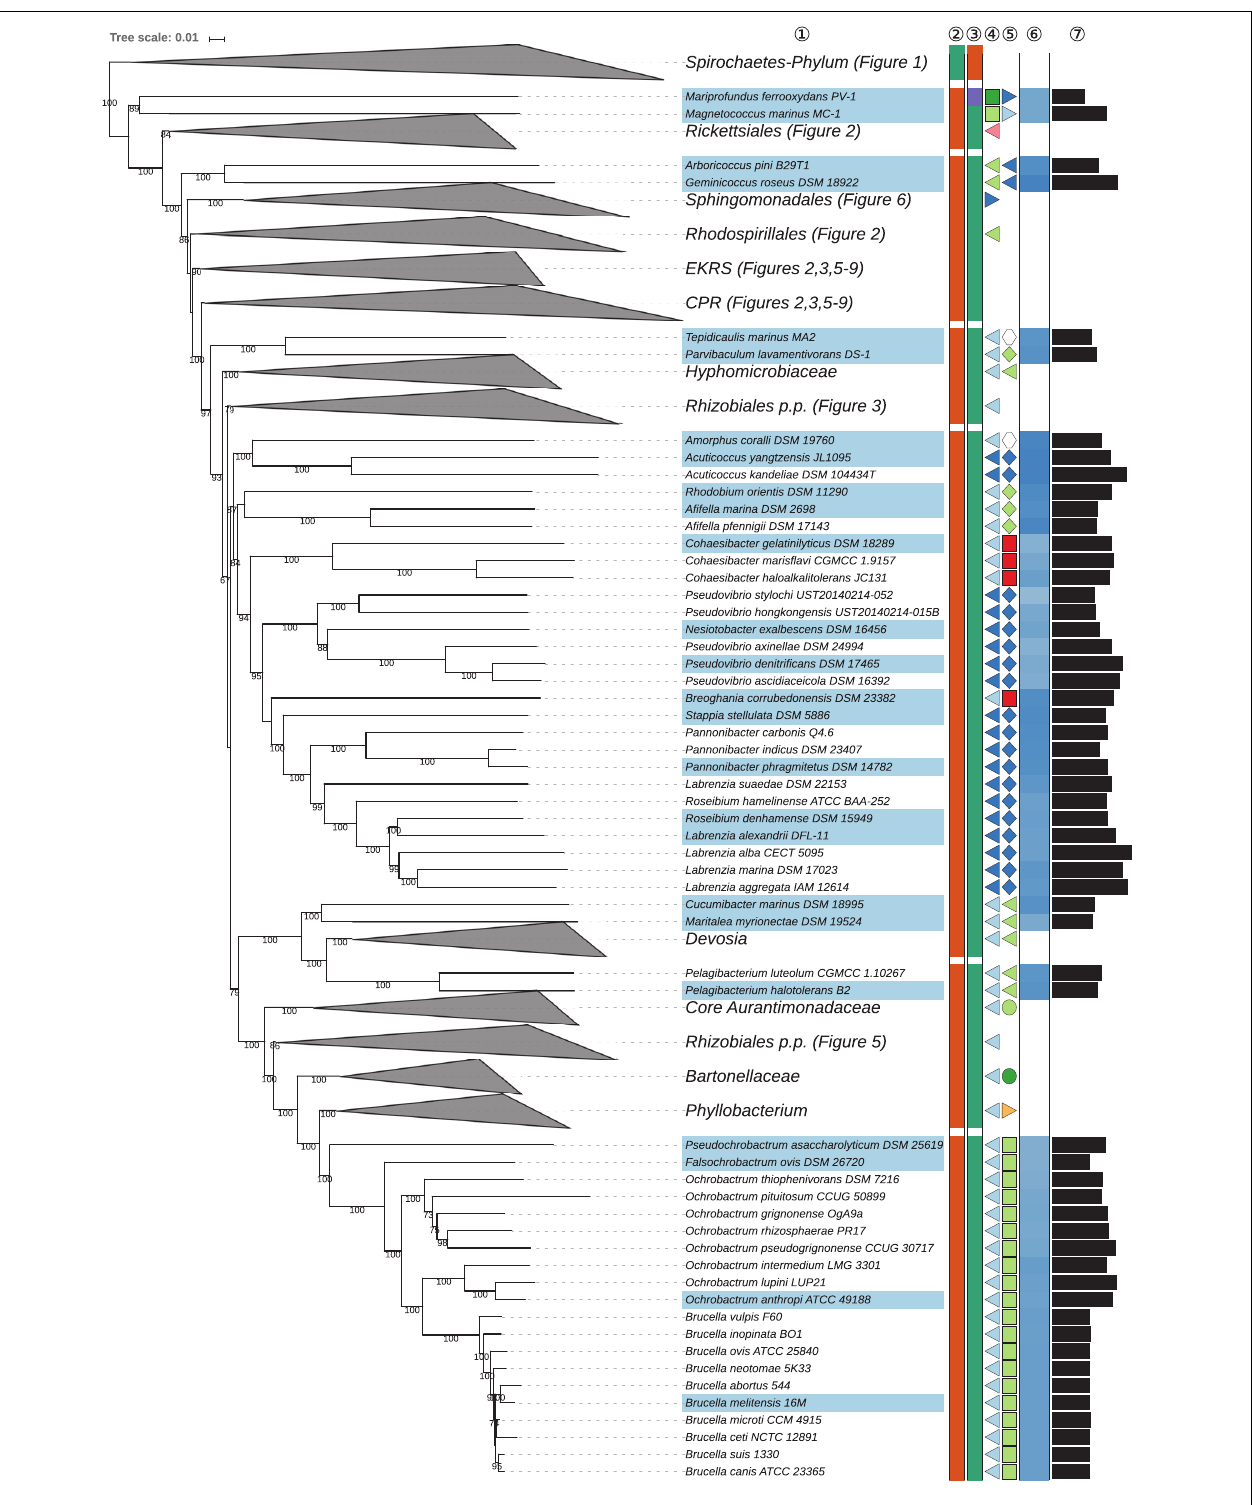
FIGURE 4 | Third part of the GBDP tree shown in Figure 1 , focussing on parts of Rhizobiales ( Hyphomicrobiales ). The clade labeled EKRS comprises the orders Emcibacterales, Kordiimonadales, Rhodothalassiales and Sneathiellales , whereas CPR denotes the clade including the orders Caulobacterales , Parvularculales, and Rhodobacterales , details for which are shown in the subsequent figures. Tip labels with light-blue background indicate type species of genera, colors and symbols to the right of the tips indicate, from left to right, phylum, class, order and family; for details and abbreviations see Figure 1 . The blue color gradient indicates the G+C content as calculated from the genome sequences, followed by black bars indicating the (approximate) genome size in base pairs.